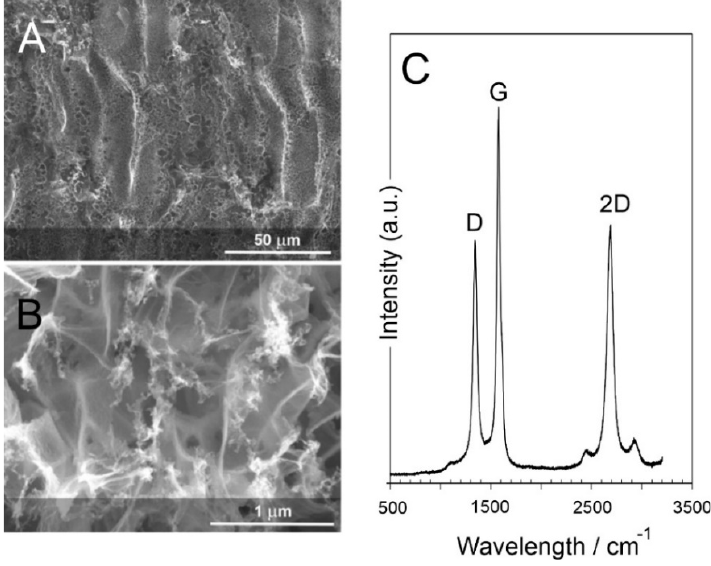
Figure 5. Scanning electron micrograph of the LIG film highlighting the micro/nano porosity ( A ) and abundance of fragmented structures ( B ). ( C ) Raman spectrum of the LIG film.